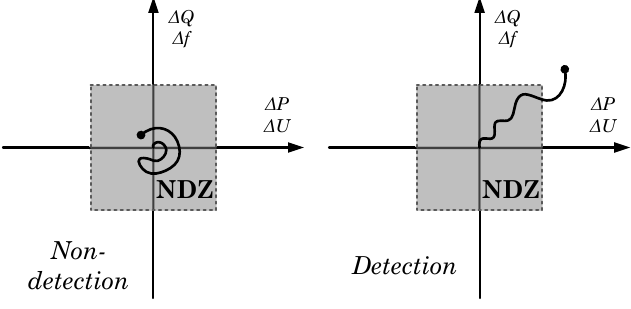
Figure 3. Non-detection zone